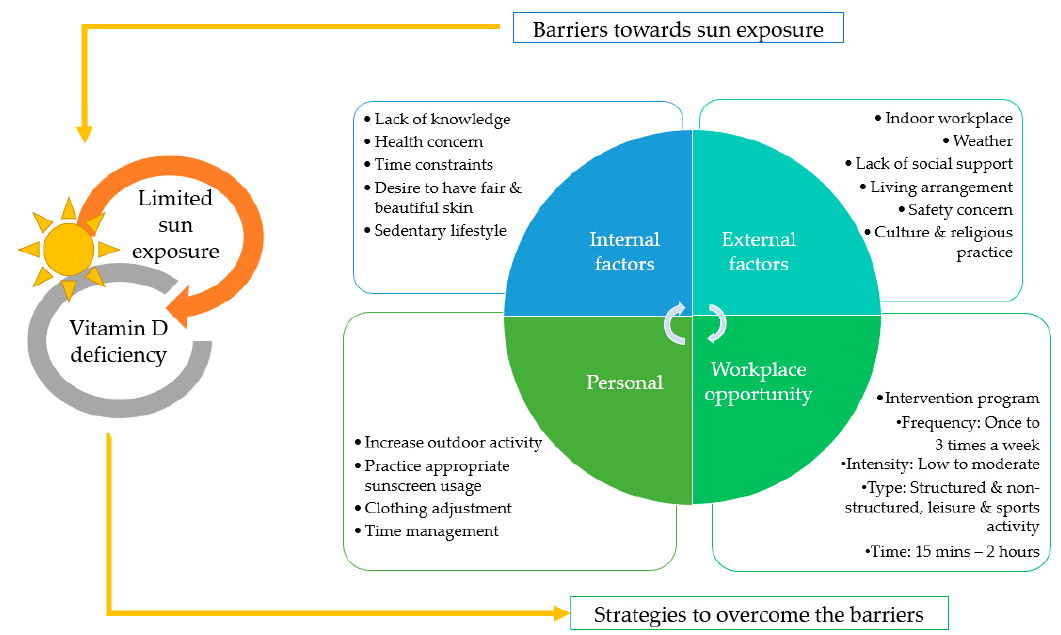
Figure 1. Barriers and improvement strategies to improve sun exposure for vitamin D.